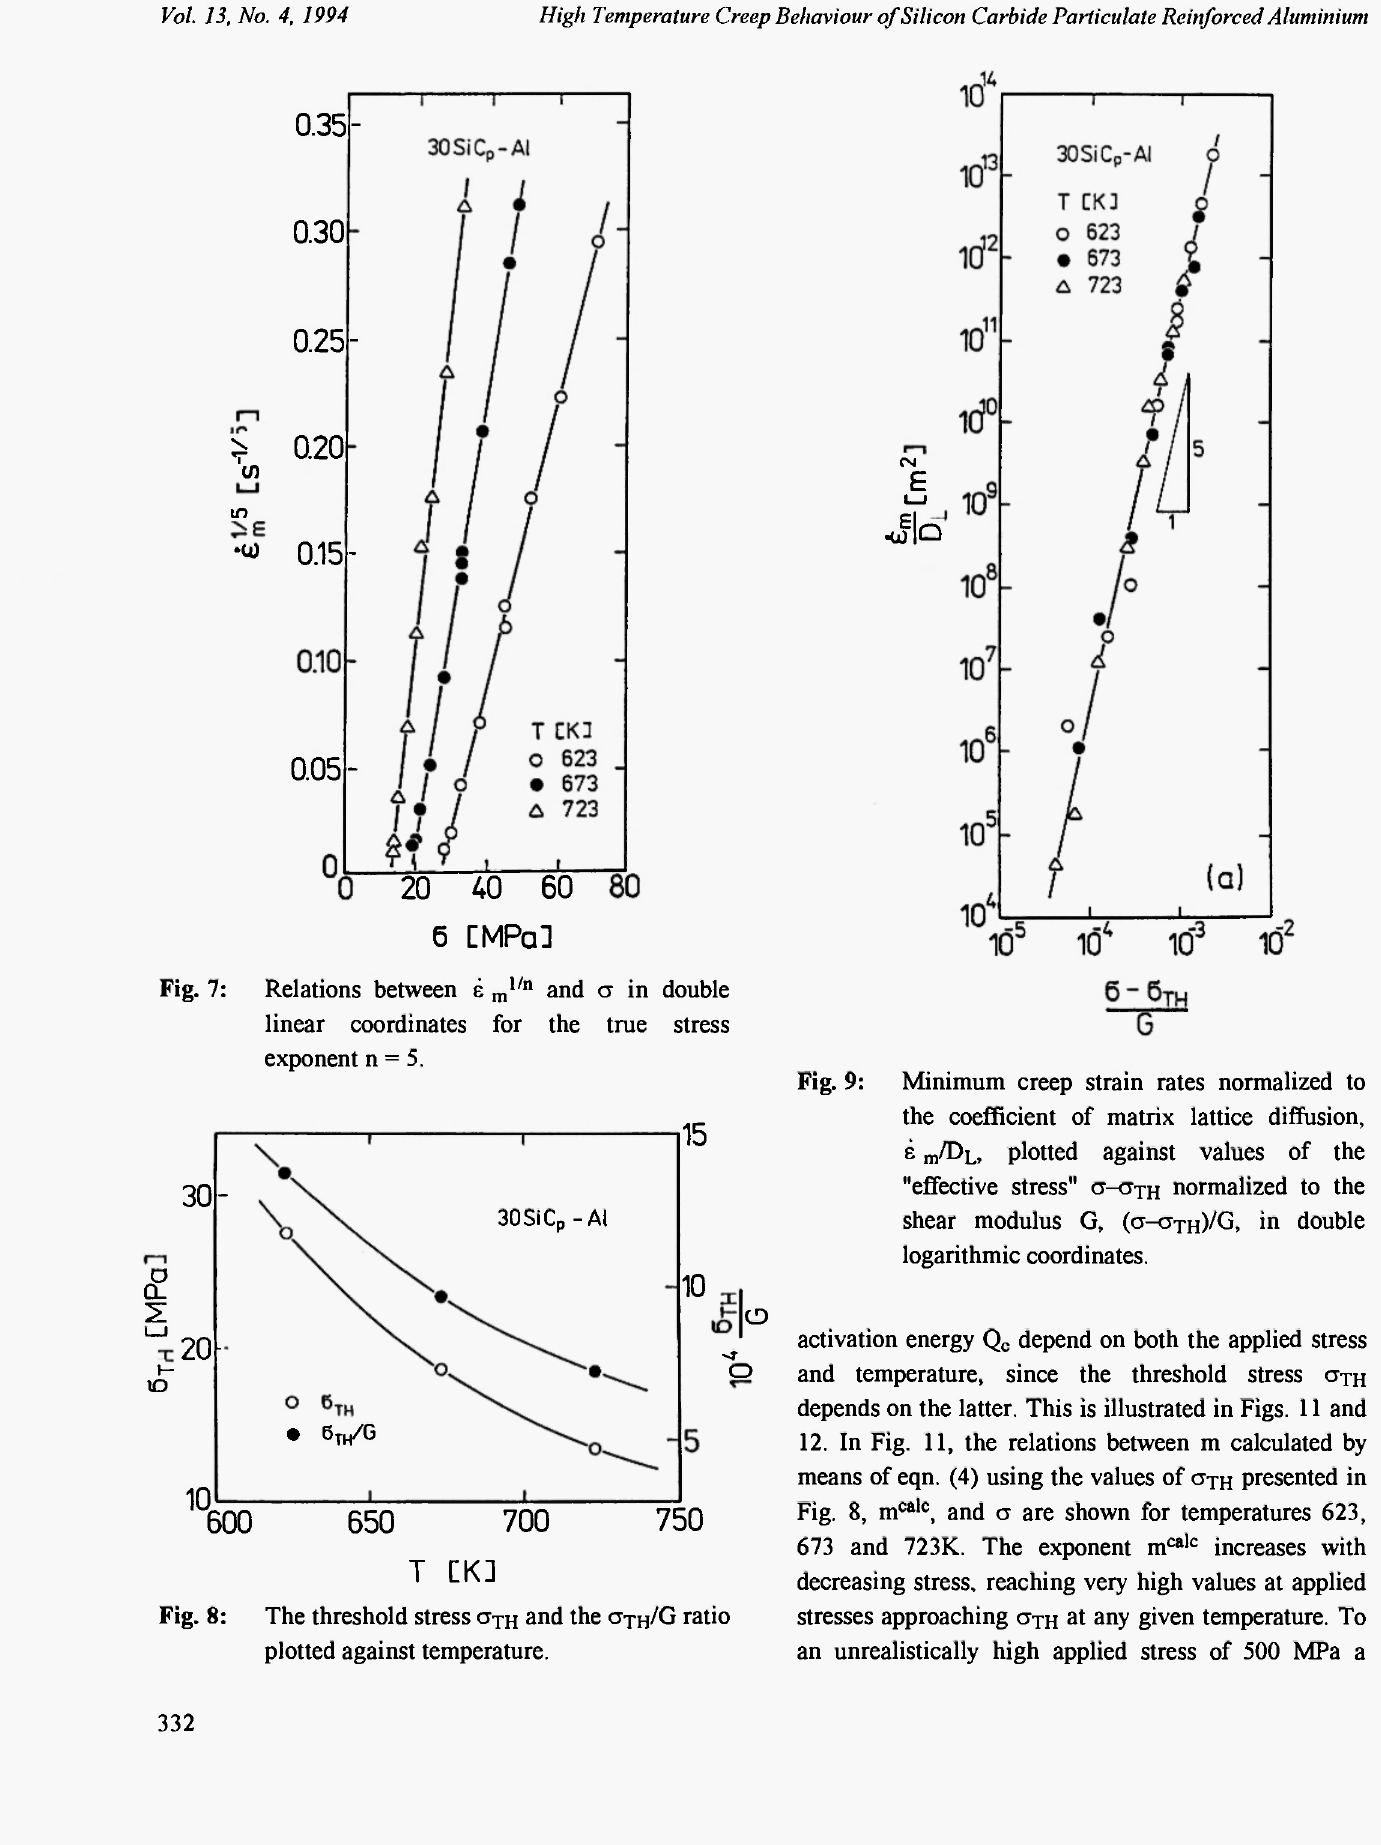
Fig. 8: The threshold stress σ ΤΗ and the σχπ/G ratio plotted against temperature.